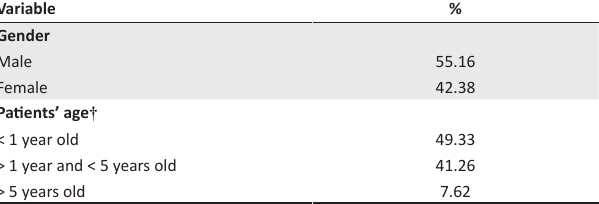
TABLE 1: Gender and age of patients with enterovirus-positive specimens. Variable % Gender